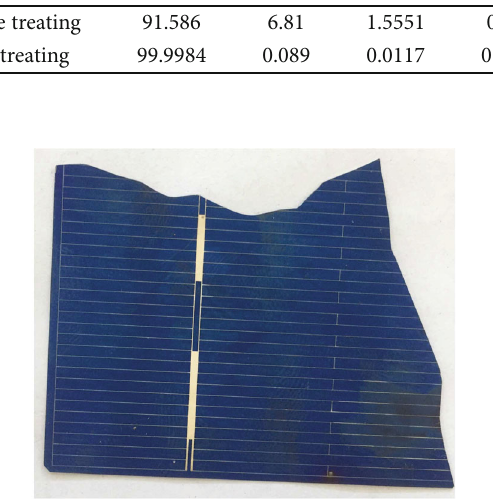
Figure 1: Top layer of solar cell which contains antire fl ecting coating and silver electrodes.